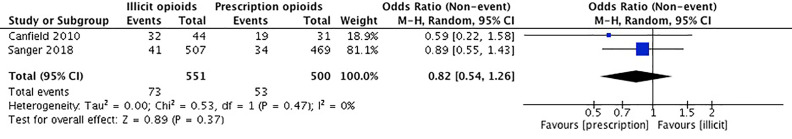
Forest Plot for Benzodiazepine Use.